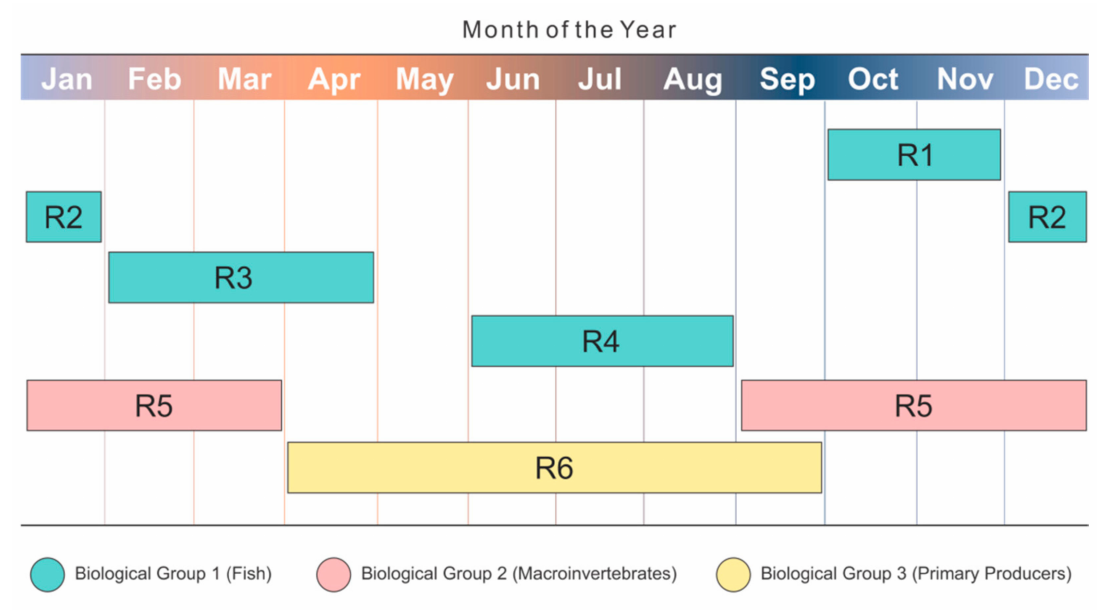
Figure 4. Annual distributions of e-flow requirements defined for the Pas River. Each requirement was translated into the ecological objectives within the optimization model for water